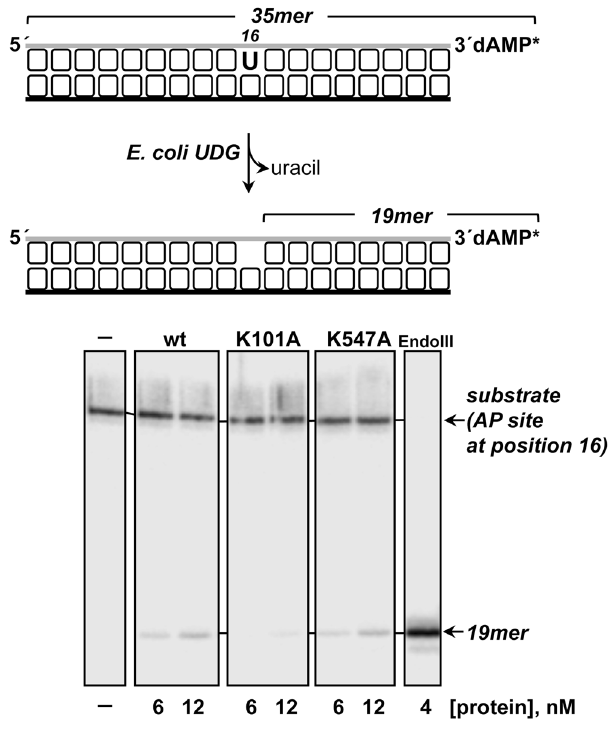
Figure 7. AP-lyase activity of PgVPolX . The depicted [ 32 P]3 ′ -labeled uracil-containing oligonucleotide (top) was treated with E. coli UDG, leaving an intact AP site. The resulting AP-containing DNA (1 nM) was incubated in the presence of either E. coli EndoIII that incises 3 ′ to the AP site, or the indicated PgV-PolX for 10 min at 30 °C, as described in Materials and Methods. Position of products is